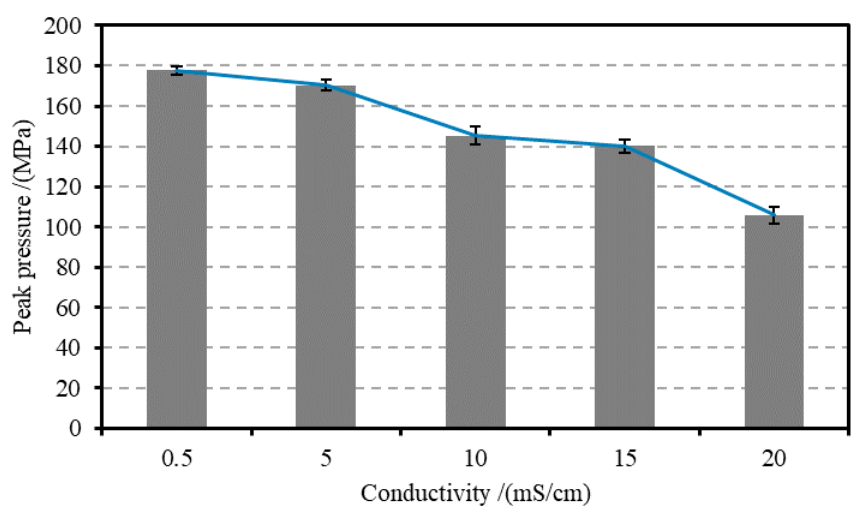
Figure 14. Peak pressure generated by electrical discharge under different conductivity.